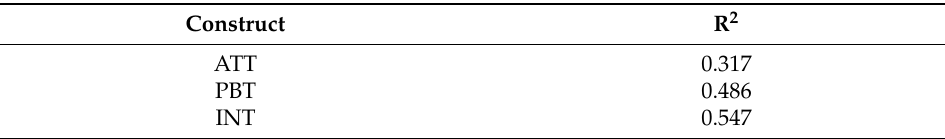
Table 4. Coefficients of